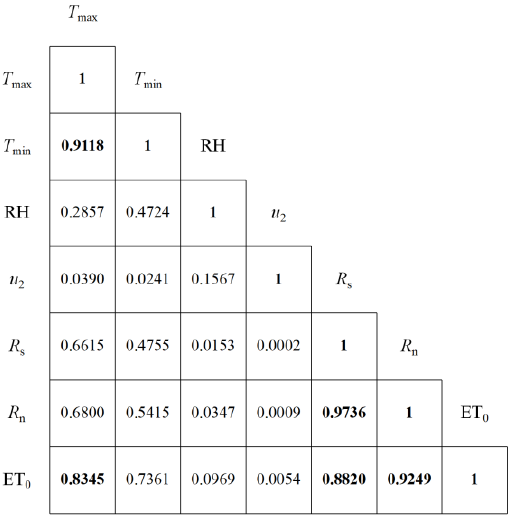
Figure 4. R 2 of meteorological parameters for ET 0 estimated using the Penman – Monteith model. Table 2. Summary of the input data for each ET 0